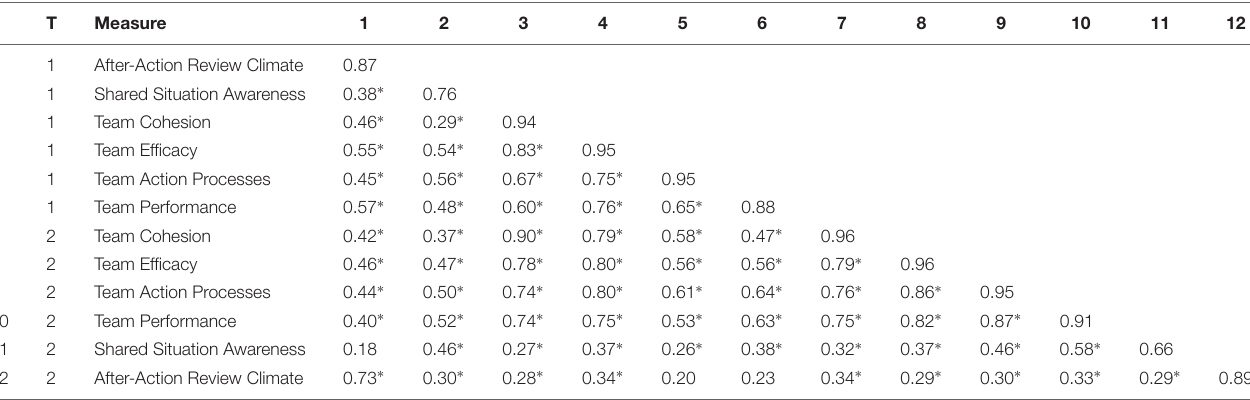
TABLE 3 | Pooled within group correlations among team attitudes and shared situation awareness following live training scenarios M2 (Time 1) and M3 (Time 2), n = 59.